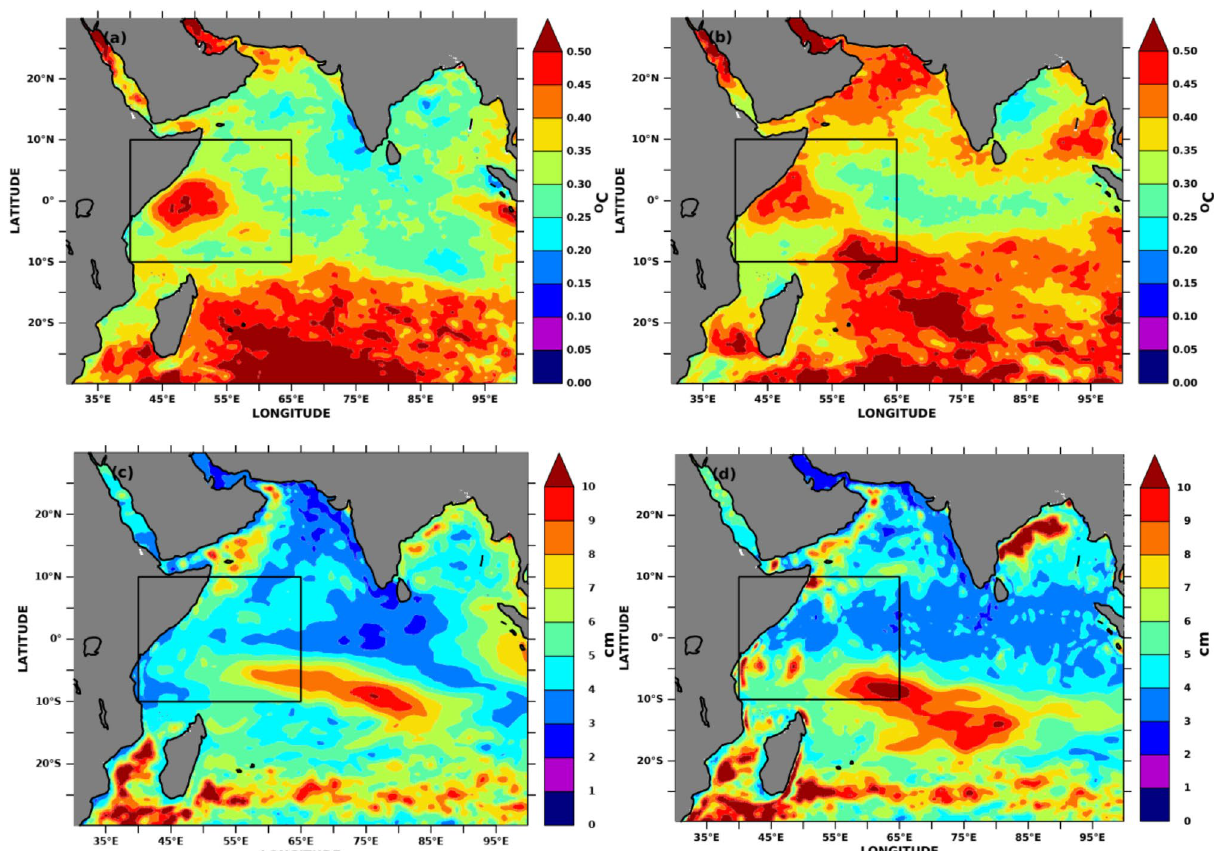
Figure 4. SSTA and MSLA standard deviation in the Indian Ocean. SSTA standard deviation during ( a ) winter months (Nov–Jan) ( b ) summer months (Mar–May). MSLA standard deviation during ( c ) winter months (Nov– Jan) and ( d ) summer months (Mar–May). Standard deviations are computed by using the annual means for 27 years. The figure is generated using PyFerret v7.63.